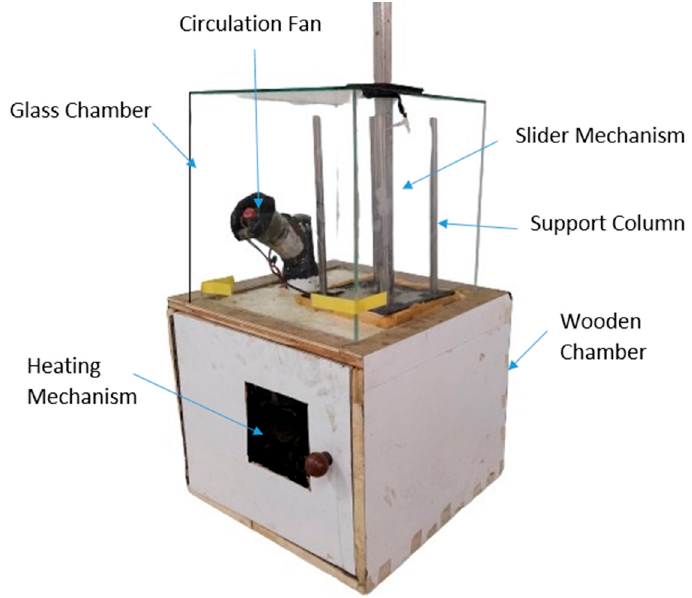
Figure 2. Schematic of vapour finishing apparatus .